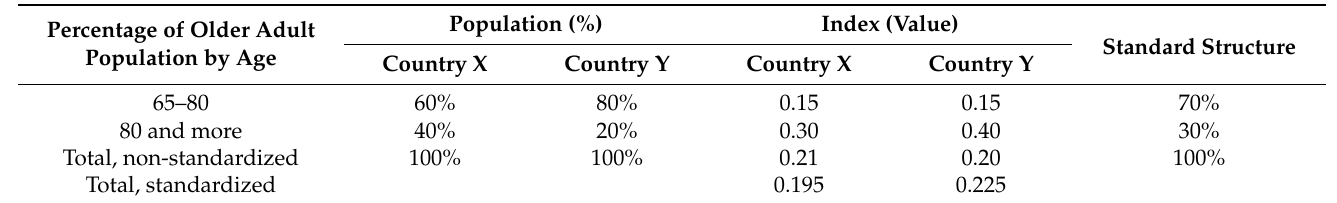
Table 5. Standardization example (for two countries).